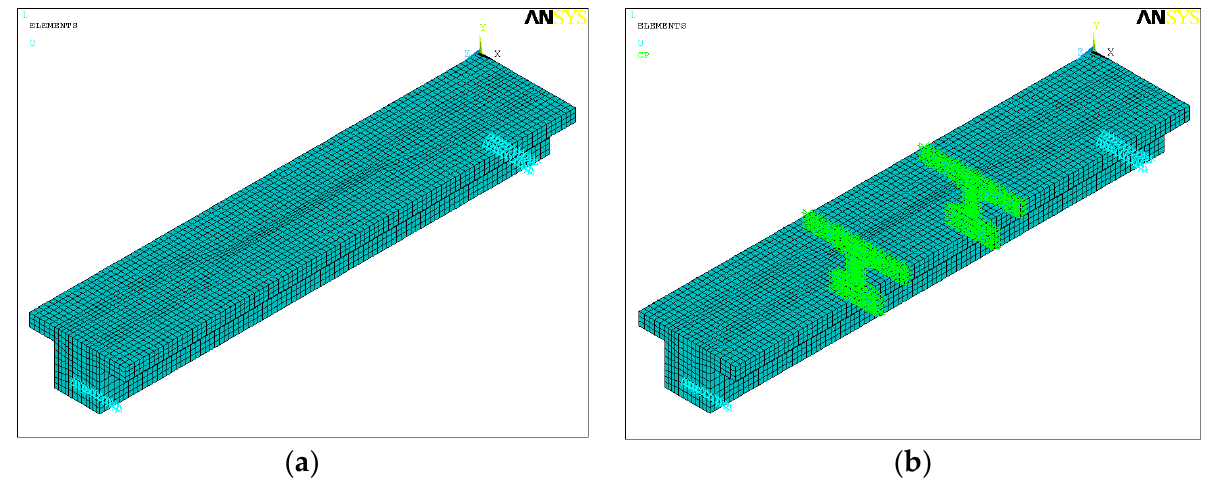
Figure 9. ANSYS finite element models of the girder specimen. ( a ) whole model of the girder specimen. ( b ) model with joints in the girder specimen.